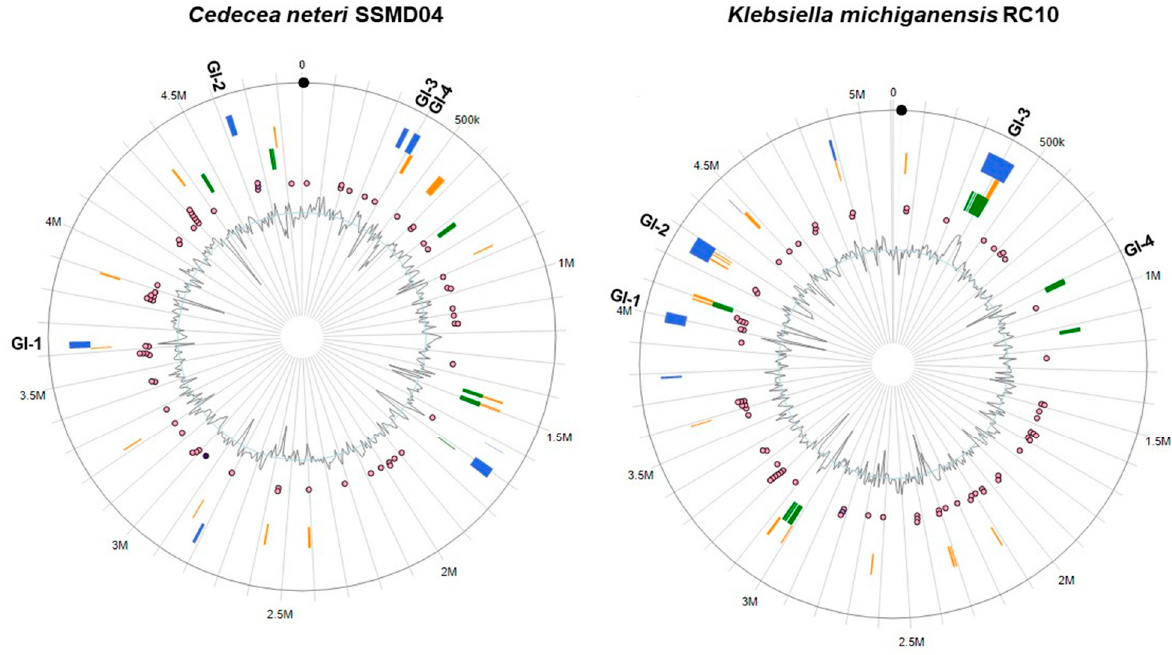
Figure 4. Predicted genomic islands (GIs) and antimicrobial resistance genes in the sequenced genomes of Cedecea neteri SSMD04 (GenBank accession number NZ_CP009451.1) and Klebsiella michiganensis RC10 (accession number NZ_CP011077.1). Solid rectangles denote GIs predicted by IslandPath-DIMOB (blue), SIGI-HMM (orange), and IslandPick (green) methods using the webserver IslandViewer 4 [35]. Selected genomic islands are labeled GI-1 through GI-4. Predicted AMR genes (pink circles) are also shown. Table 3. Annotated genes in the predicted genomic island GI-1 of C. neteri and K. michiganensis .